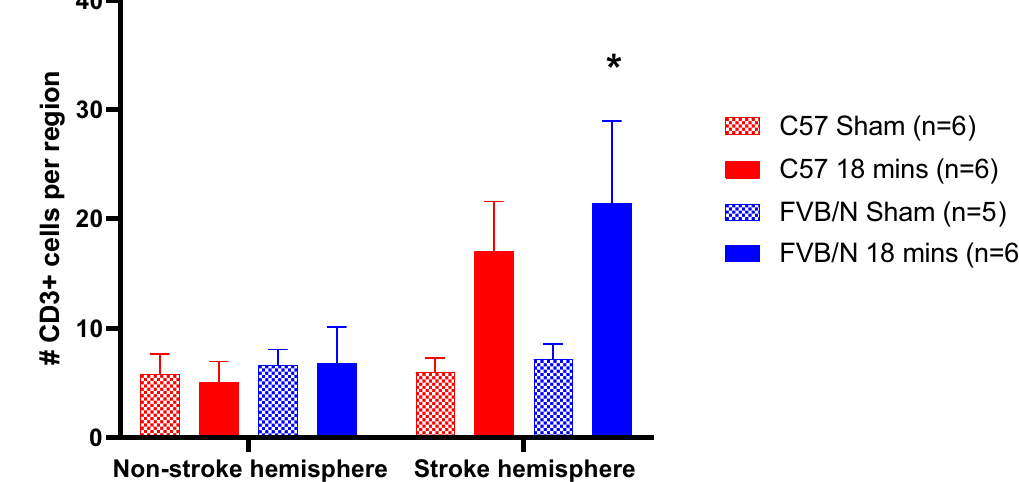
Figure 4. The total number of CD3 + cells per hemisphere of the brain in C57Bl/6 and FVB/N mice subjected to 18 min of light exposure during photothrombosis, or sham operated non-stroked mice. Data are represented as mean ± SEM, with *P < 0.05 vs non-stroke hemisphere, two-way ANOVA followed by Sidak’s multiple comparisons